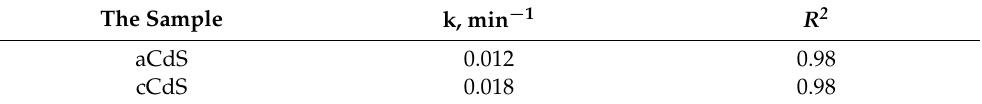
Figure 11. Kinetic linear simulation curves for Orange II photocatalytic degradation over aCdS and cCdS samples. Table 1. The parameters for the pseudo-first-order photocatalytic reaction of aCdS and cCdS. The Sample